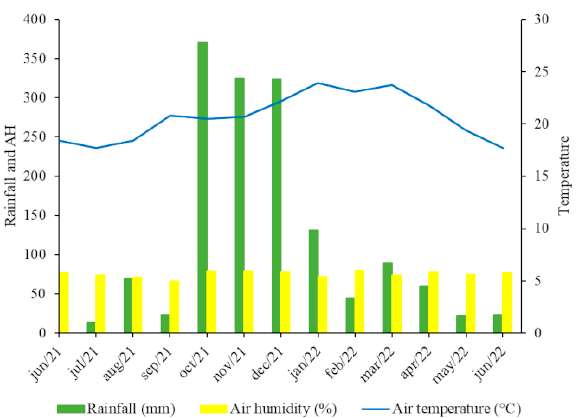
Figure 6. Climate conditions monitored during the study, considering rainfall depth (mm), relative air humidity (%), and temperature (°C), shown as biweekly means, based on daily data from June 2021 to June 2022, in Marechal Floriano, ES, Brazil.